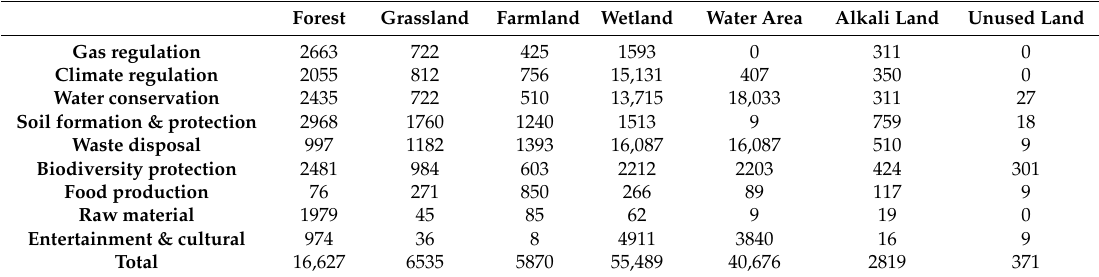
Table 2. Ecosystem services value per unit area of different land ecosystems in Western Jilin (yuan · ha − 1 · yr − 1 ) 1